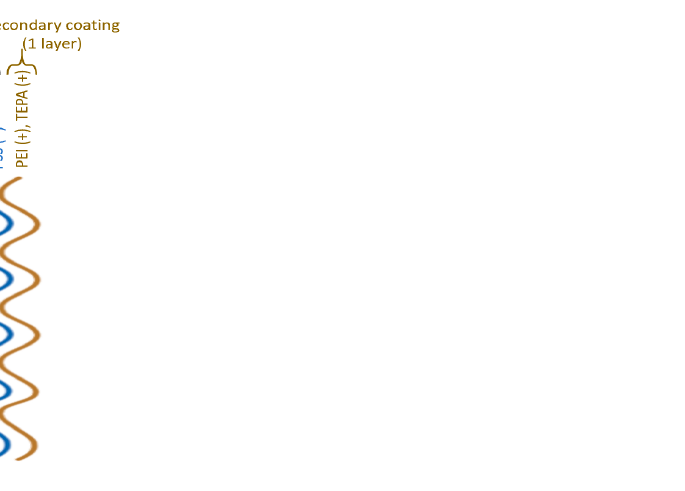
Figure 1. Layer-by-layer polyelectrolyte membrane fabricated on polyHIPEs surface.